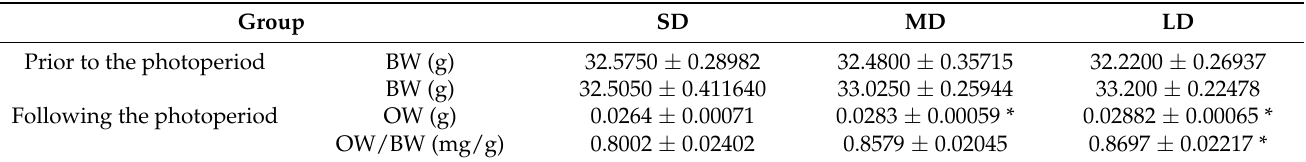
Table 1. Differences in the body and ovarian weights among hamsters under different photoperiods.